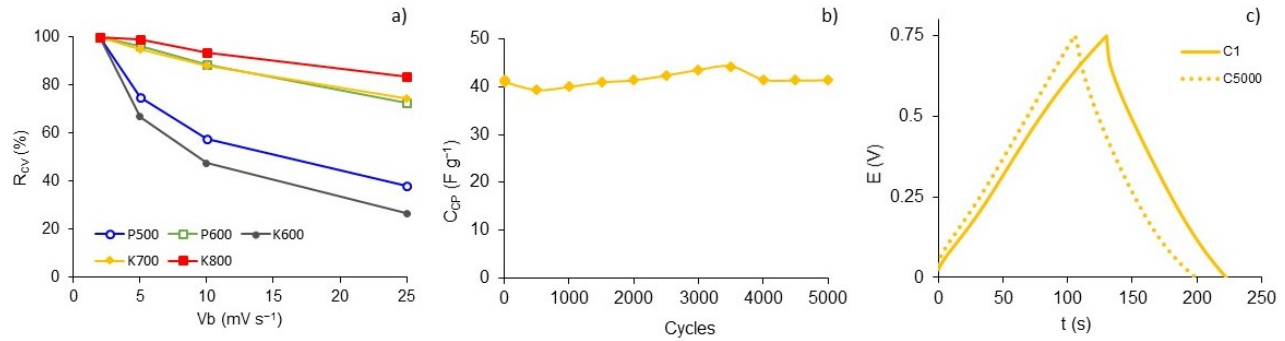
Figure 10. ( a ) Capacitance retention as a function of different scan rates, ( b ) gravimetric capacitance